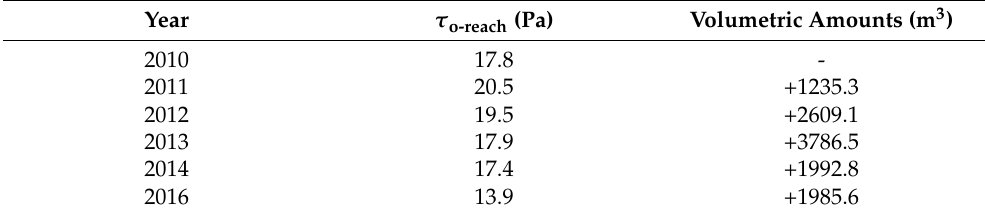
Table 9. Estimated values of the reach-averaged τ o ( τ o-reach ) and volumetric amounts of geomorphic change based on field observations from post-restoration monitoring reports. Year τ o-reach (Pa) Volumetric Amounts (m 3 ) 2010 17.8 -